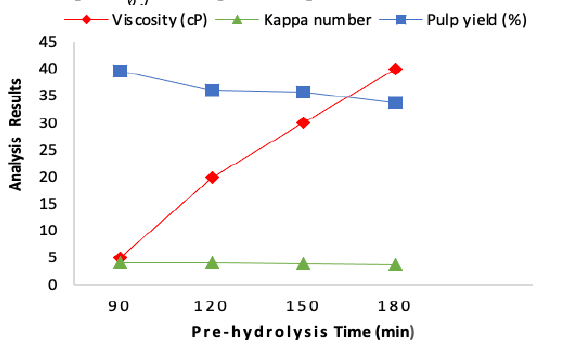
Fig. 1. Effects of pre-hydrolysis (150 o C) AA (15%) on Kraft-anthraquinone